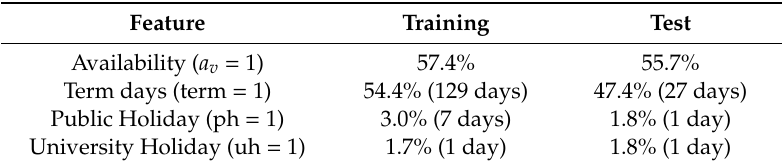
Table 3. Composition of the training and test